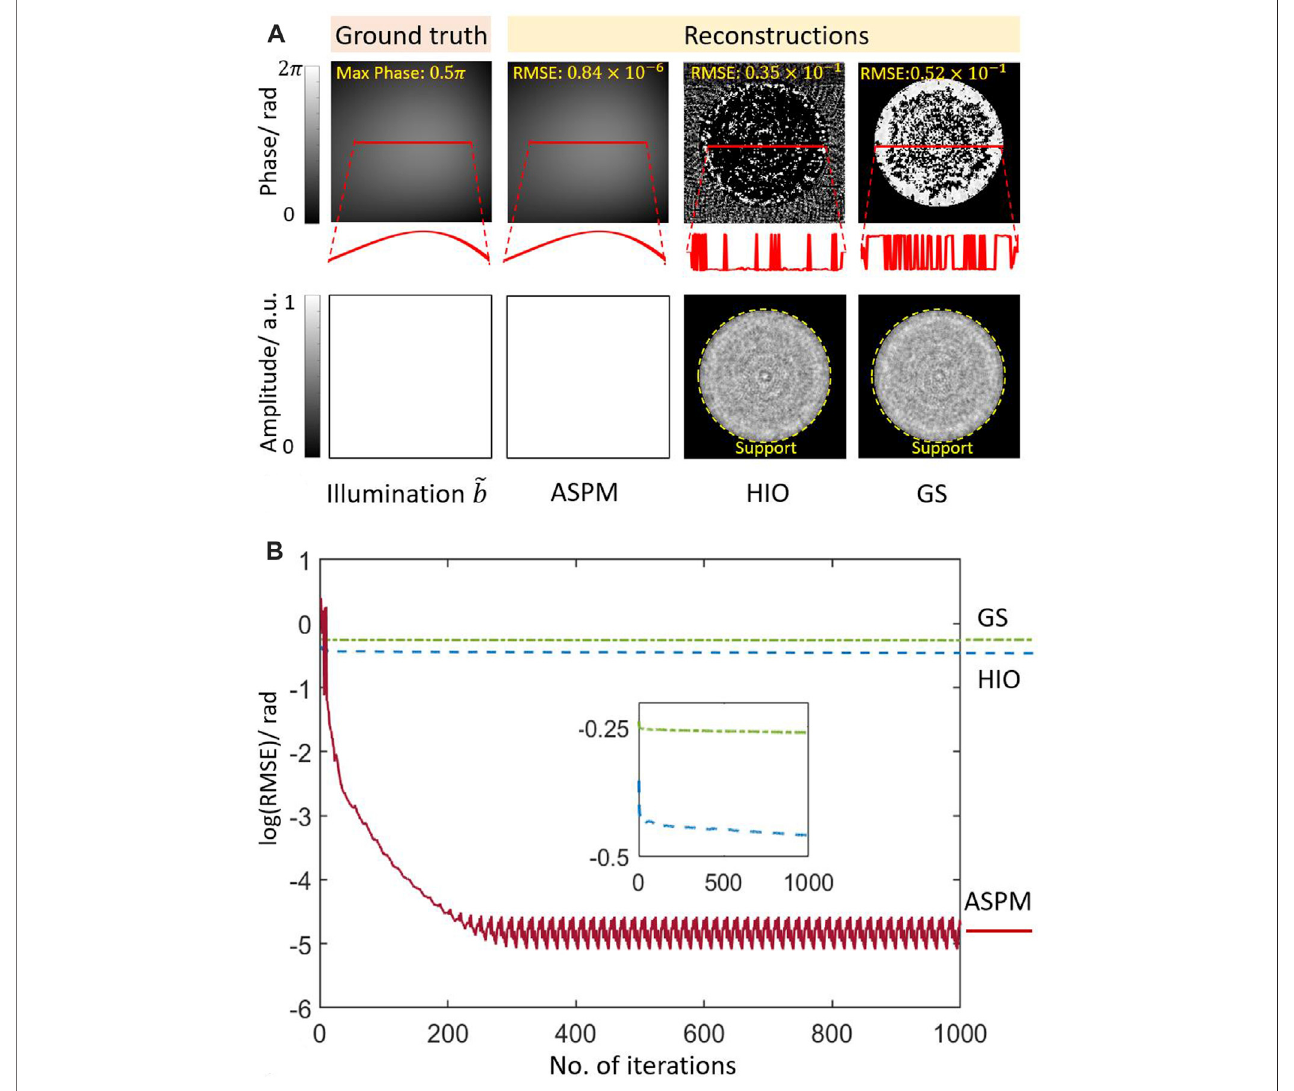
FIGURE 3 | (A) Ground truth of the wavefront and reconstructed phase and amplitude components using the ASPM, HIO, and GS methods. (B) The logarithm of the RMSE of the ASPM, GS, and HIO methods with 1000 iterations. log (RMSE): logarithm of the RMSE of the calculated phase and the ground truth.